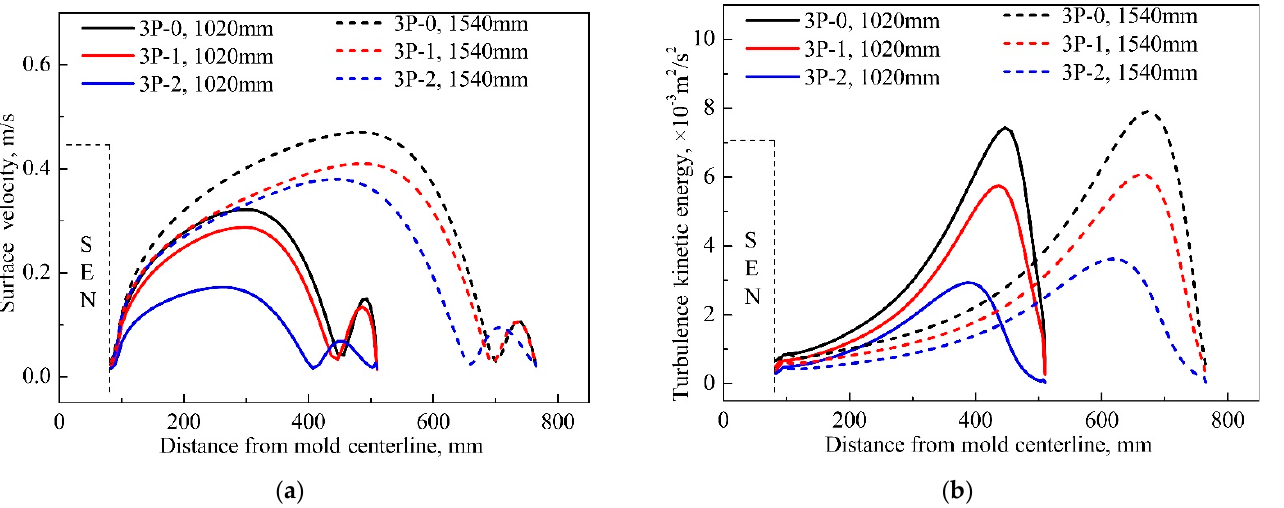
Figure 8. Comparisons of the ( a ) surface velocity and ( b ) turbulent kinetic energy profile along width direction of the level centerline.